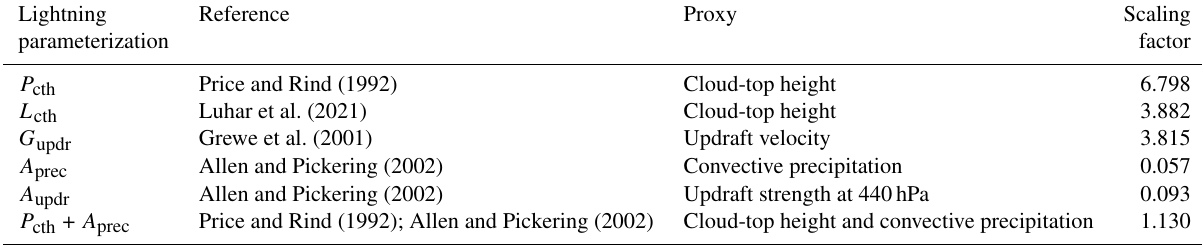
Table 1. Lightning scaling factor used for each lightning parameterization.